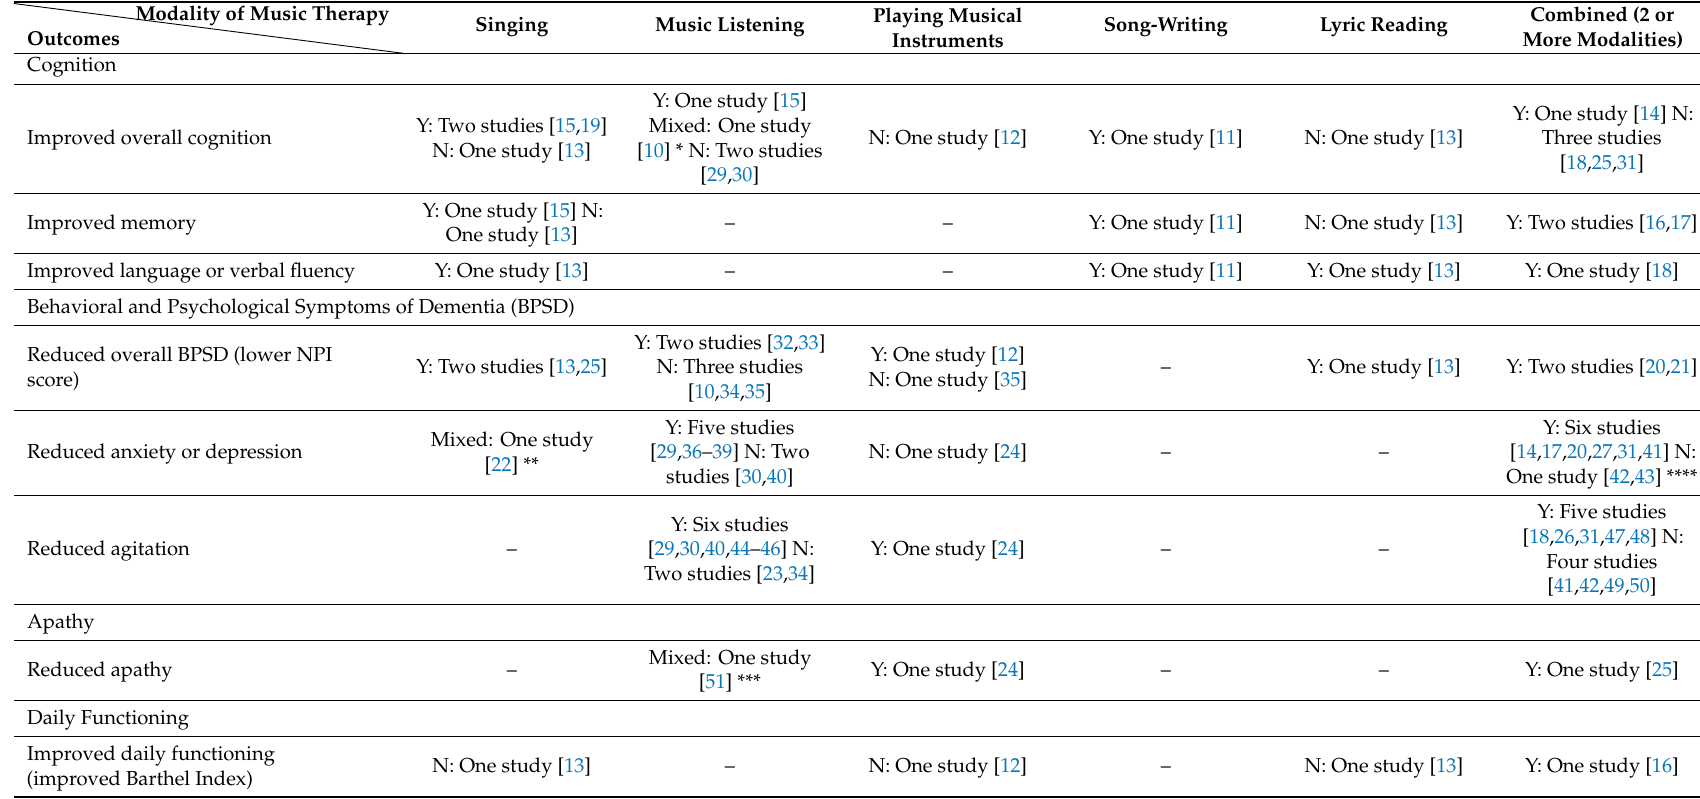
Table 3. Summary of studies on music therapy on